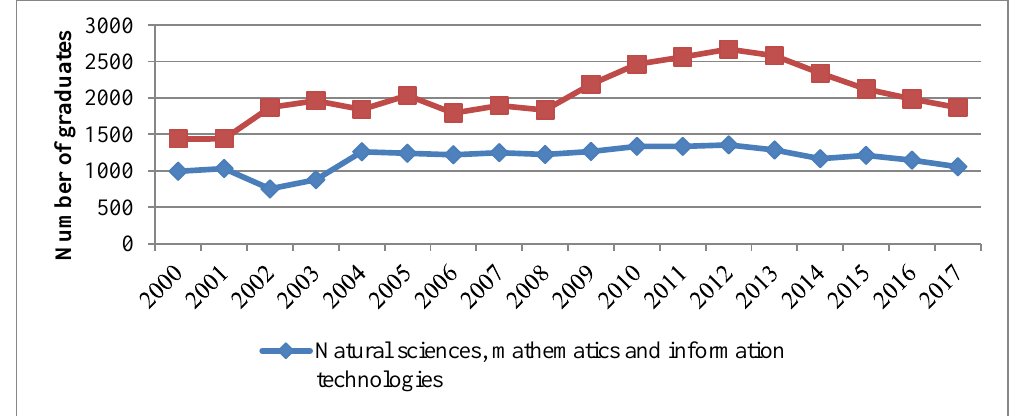
Fig. 3. Graduates with a degree or a qualification in higher education institutions and colleges of Latvia in selected education thematic groups (CSB,